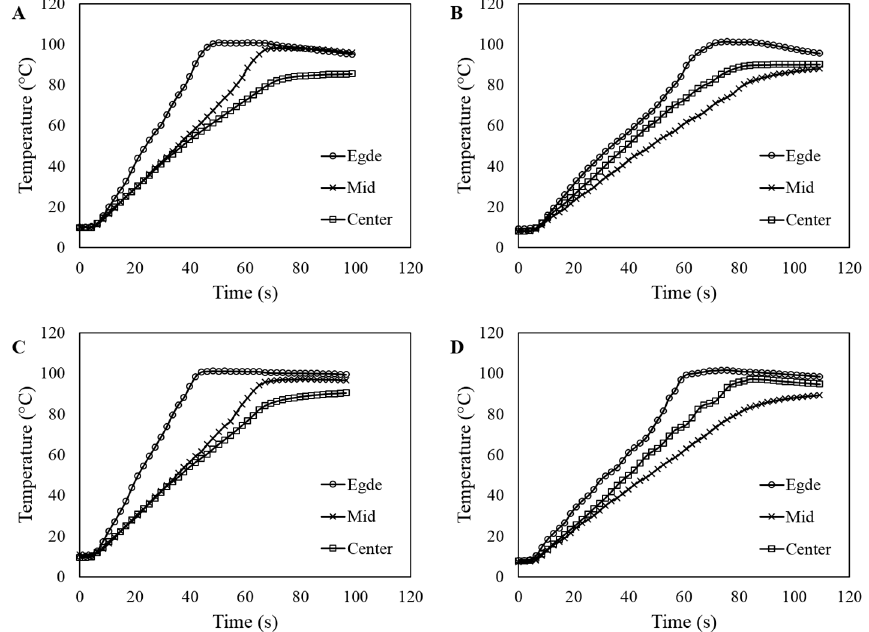
Figure 4. Time–temperature profile at the edge, mid-way, and the center position of the pork patties containing different salt and water levels in the container with an edge-perforated lid during micro- wave heating. ( A ) Pork only (PL), ( B ) Pork + salt 2% (PS), ( C ) Pork + water 10% (PW), ( D ) Pork + salt 2% + water 10% (PSW).